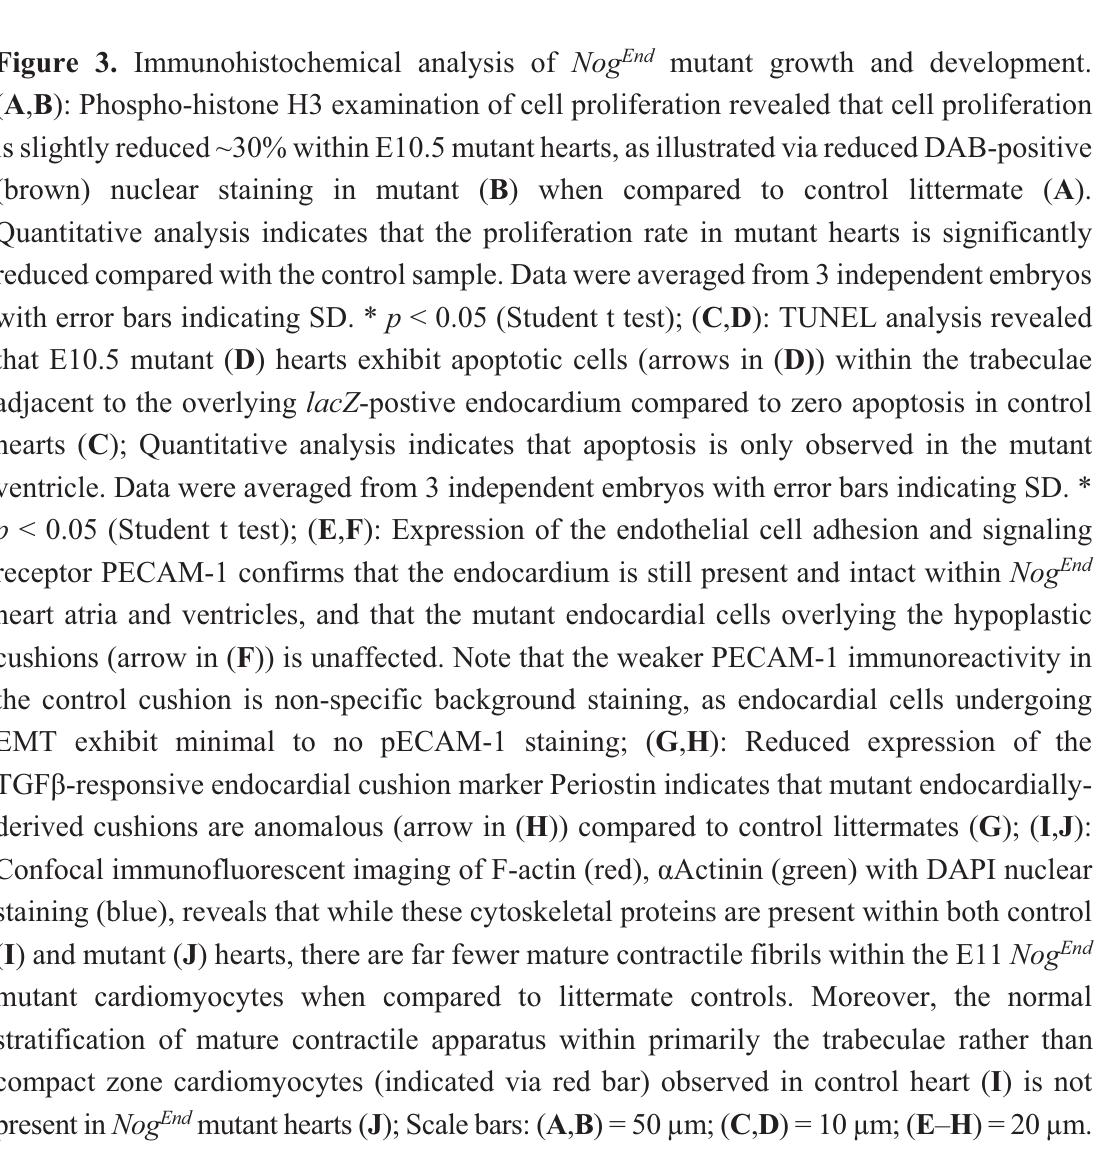
Figure 3. Immunohistochemical analysis of Nog End mutant growth and development. ( A , B ): Phospho-histone H3 examination of cell proliferation revealed that cell